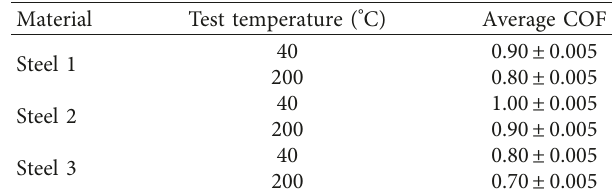
Table 4: Average COF.